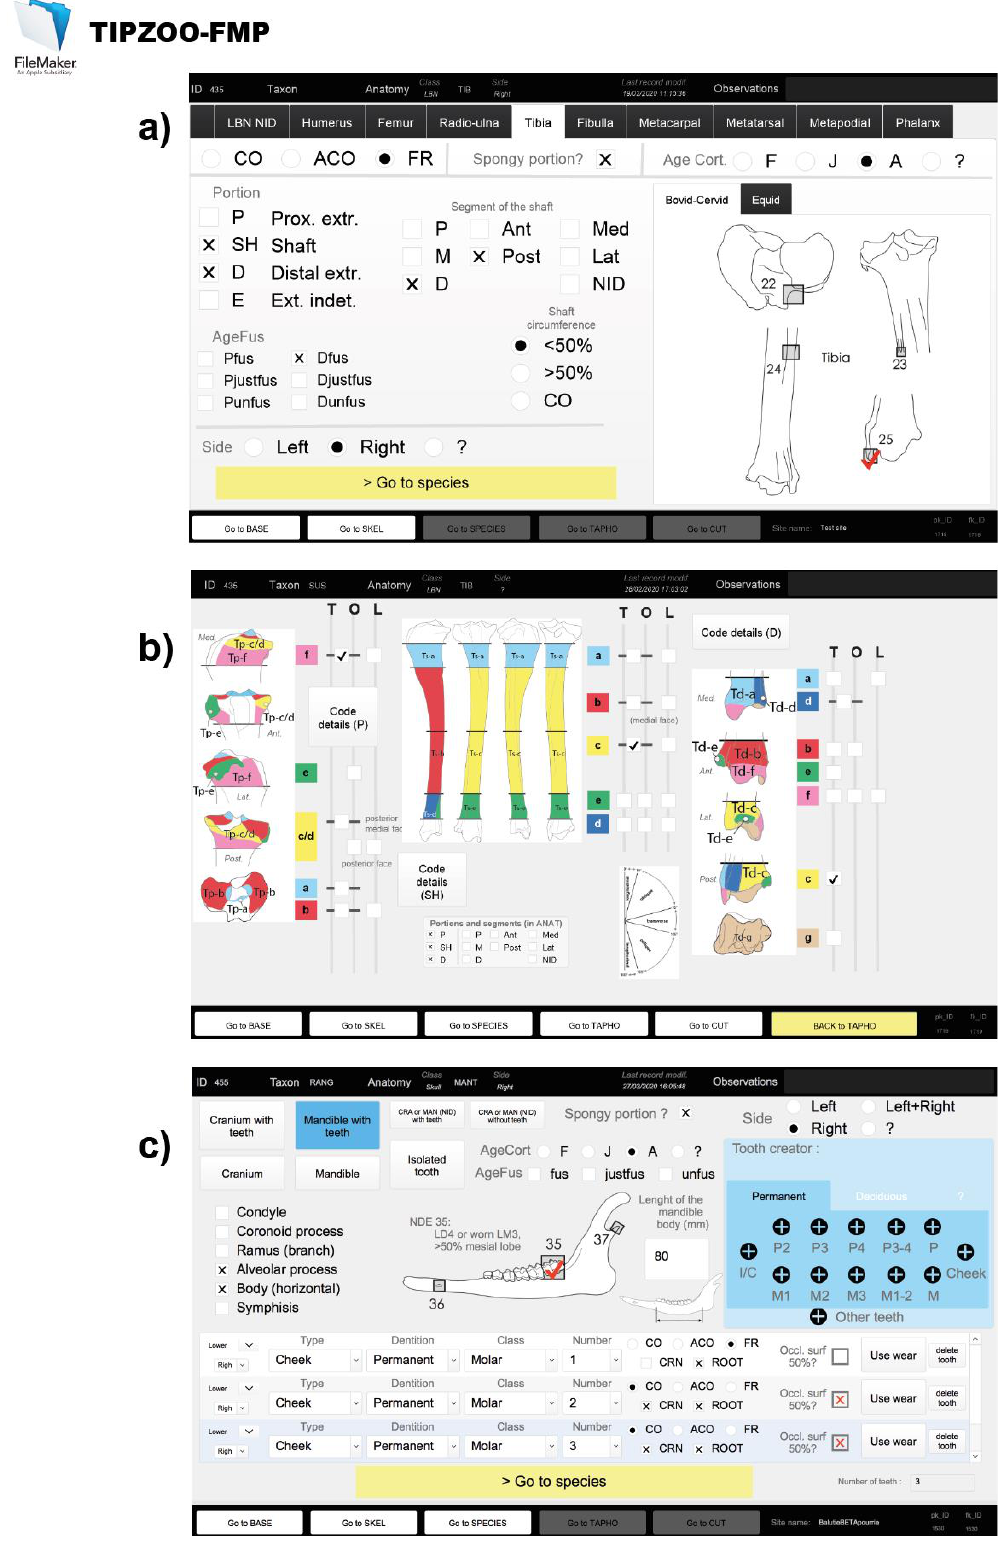
Figure 2 . Examples of three layouts from the TIPZOO-FMP interface, for recording a) bone portions of a tibia fragment (note the touchscreen box system for landmarks on the right), b) cut mark codes (with its graphically aided recording system), and c) a mandible with three enclosed teeth (note the “tooth creator” in light blue on the right, and the dual recording system for the whole mandible fragment – top part – and the three enclosed teeth – bottom